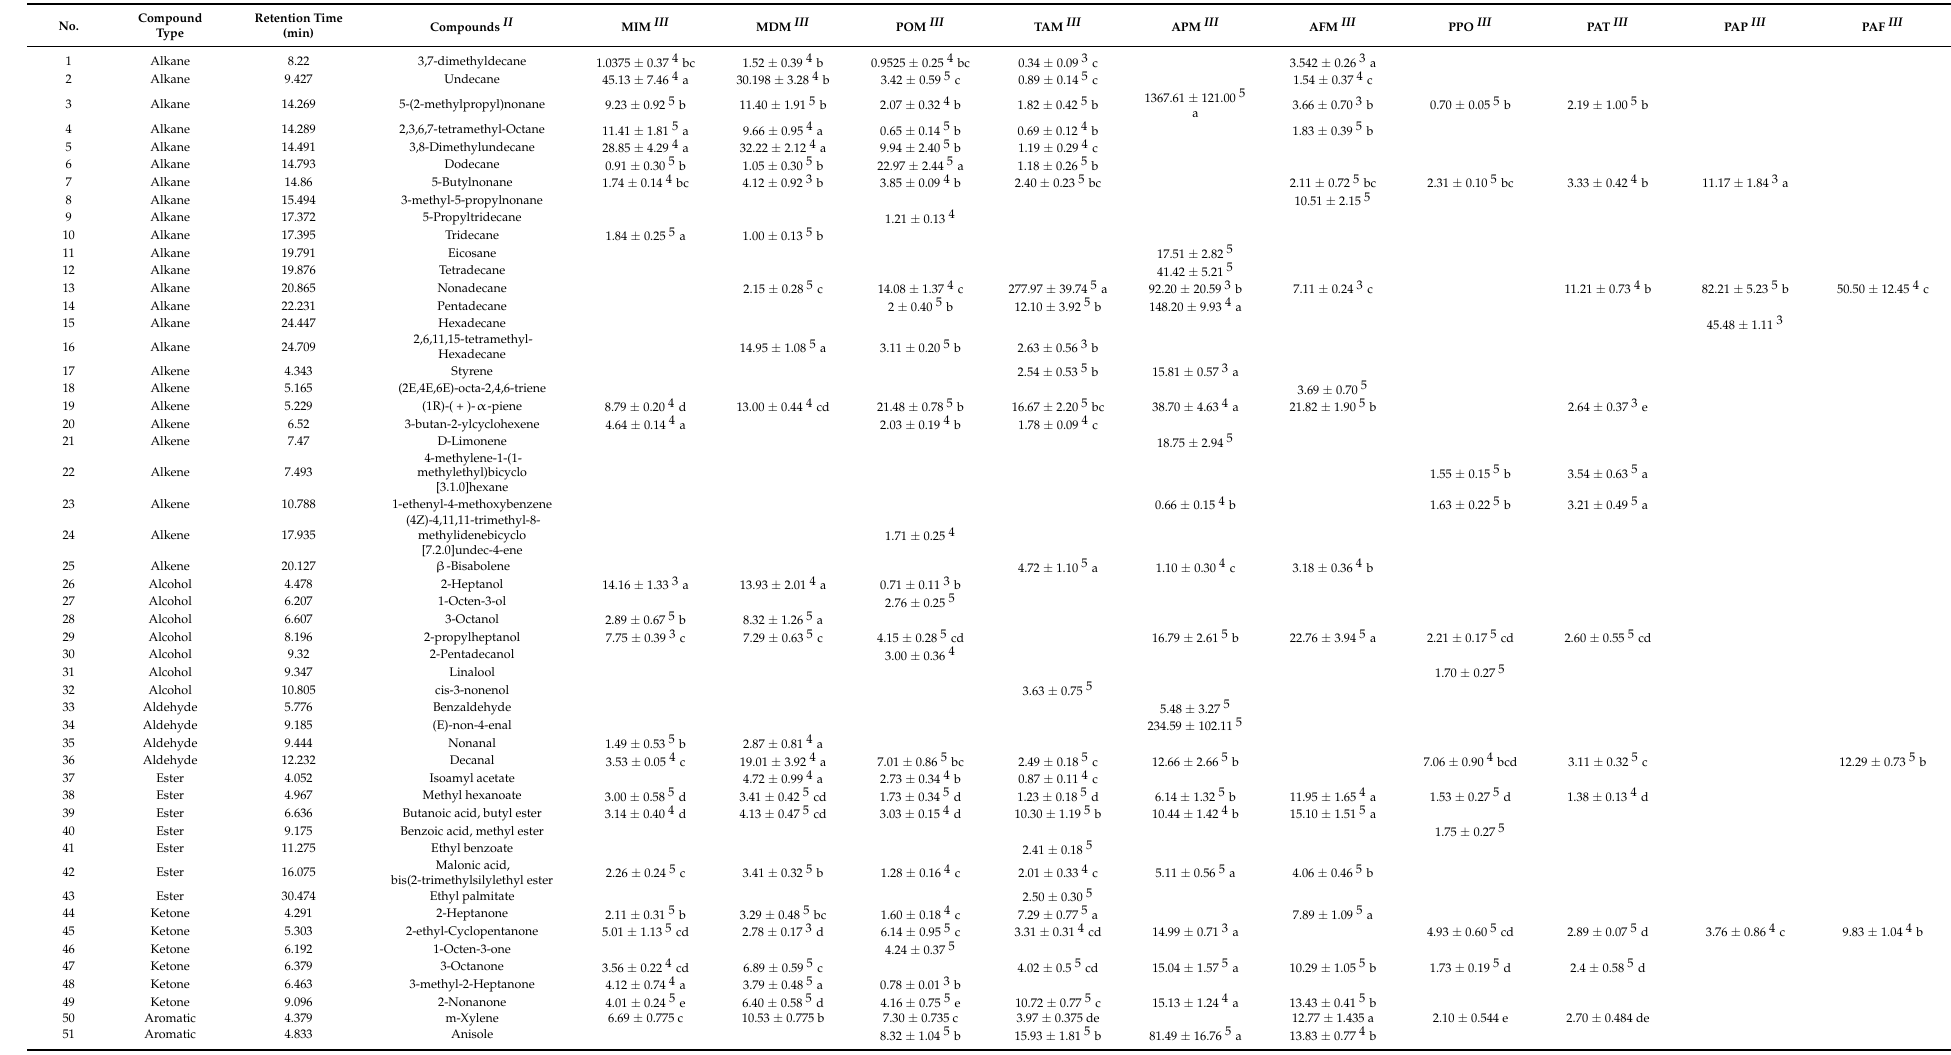
Table 2. VOCs collected from different treatments, including MIM, MDM, POM, TAM, APM, AFM, PPO, PAT, PAP, and PAF I